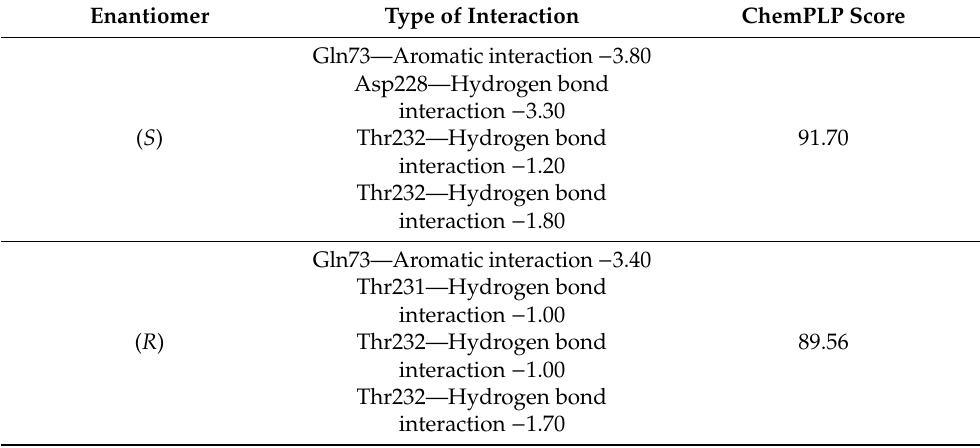
Interactions’ energy (Kcal / mol) and docking score (ChemPLP score).